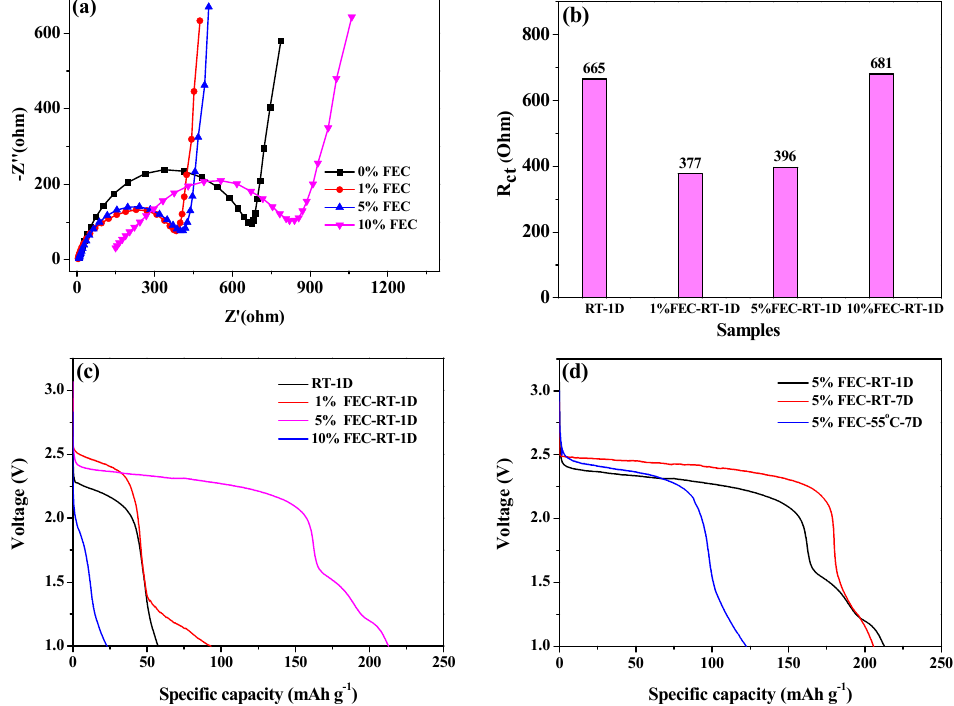
Figure 7. ( a ) The EIS plots, ( b ) Rct values, and ( c , d ) discharge curves of the lithium primary batteries with different FEC additives.